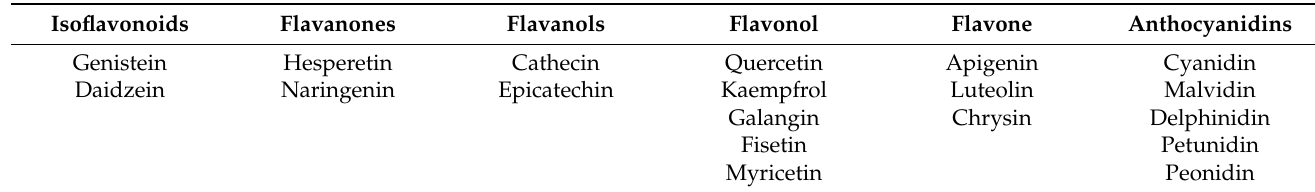
Table 2. Classification of